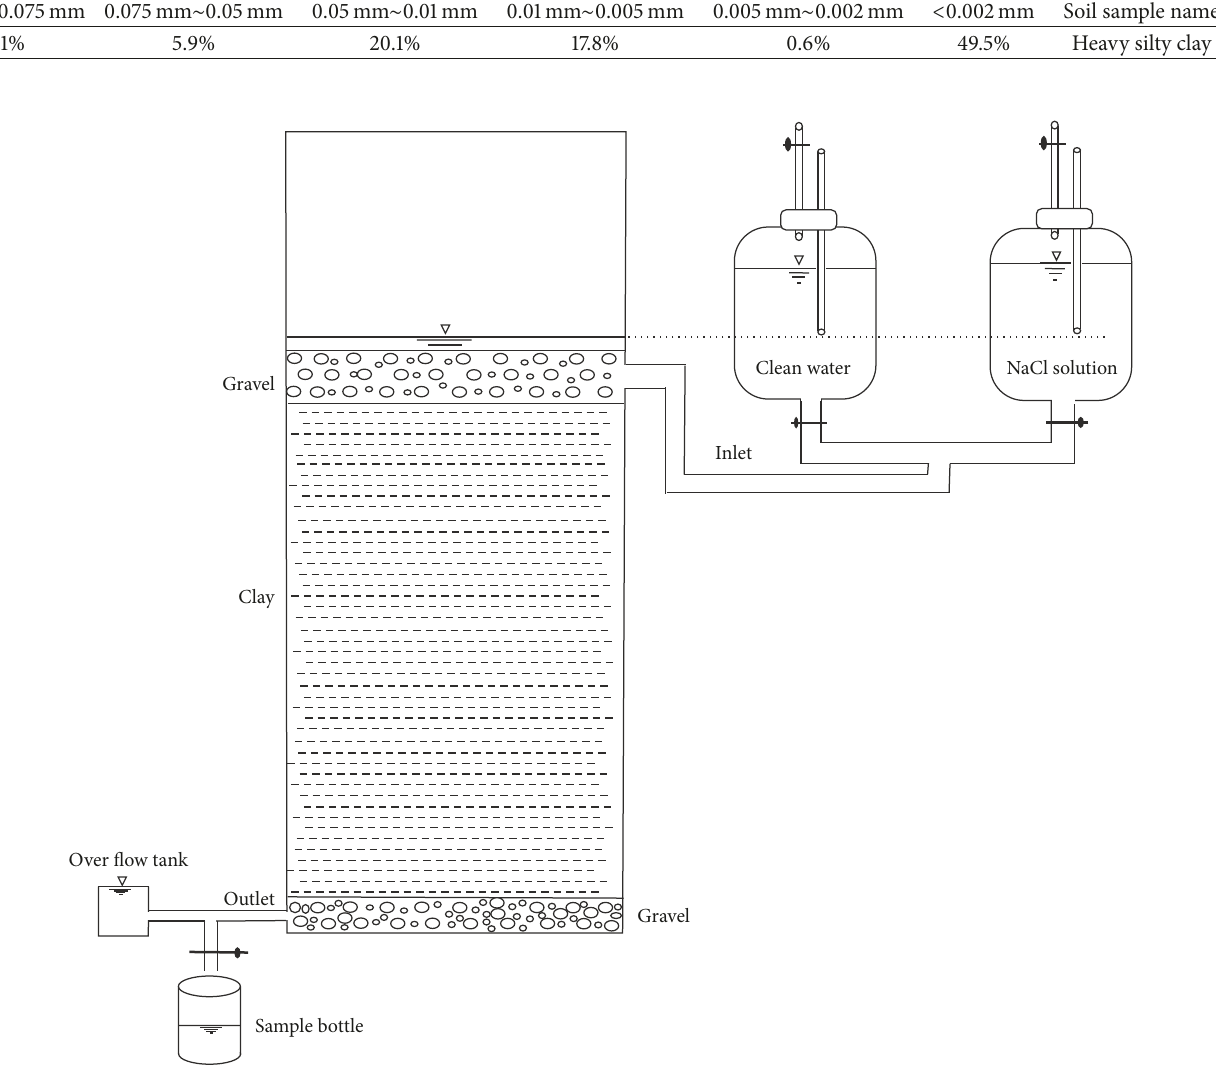
Figure 1: Schematic diagram for homogeneous and saturated columns